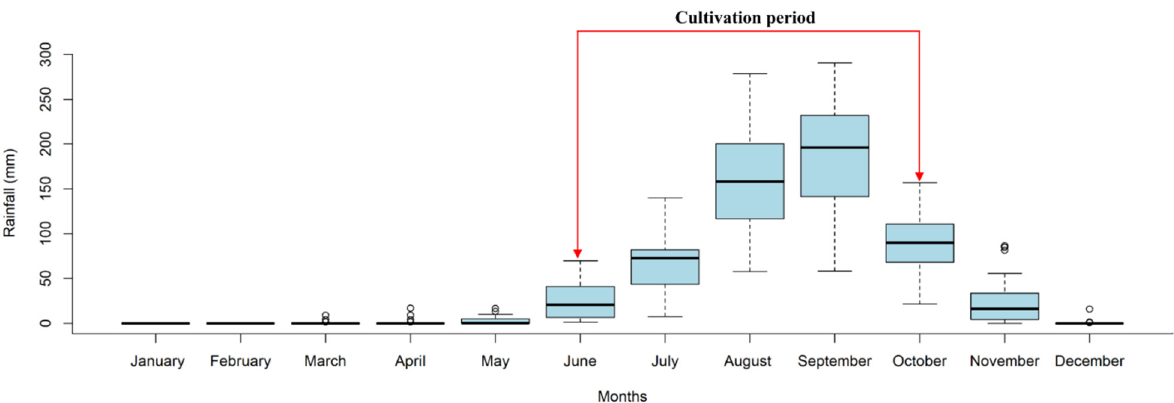
Figure 2. Boxplot showing the monthly rainfall in Gedaref state, Sudan between 1984–2018. The red arrows show the main crop cultivation period. Median rainfall values are shown by the bold lines within the boxes and the circles show outliers.